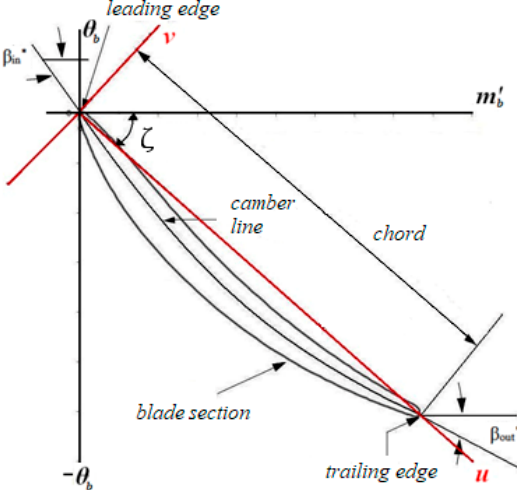
Figure 3. Blade section on the meanline curve with blade angles.